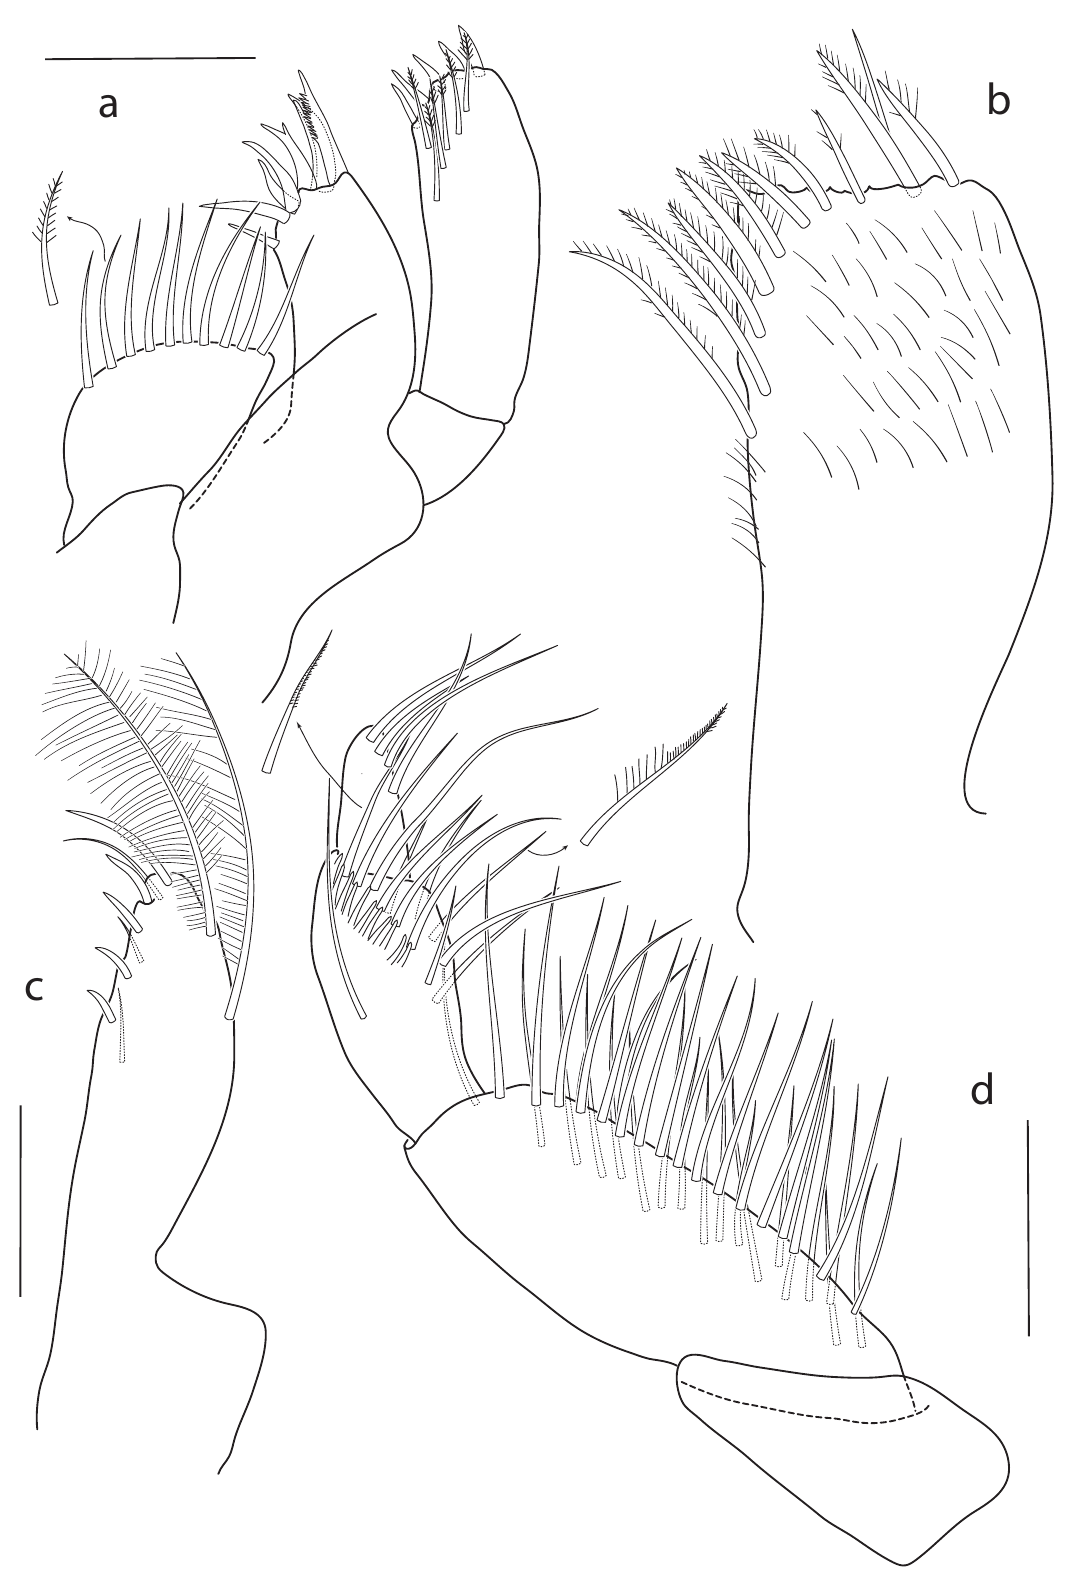
Fig. 8. Haplocheira barbimana robusta K.H. Barnard, 1932, ♂, 4.2 mm (ZMB 34098). a . Maxilla 1. b . Inner plate of maxilliped. c . Outer plate of maxilliped. d . Palp of maxilliped. Scale bars = 100